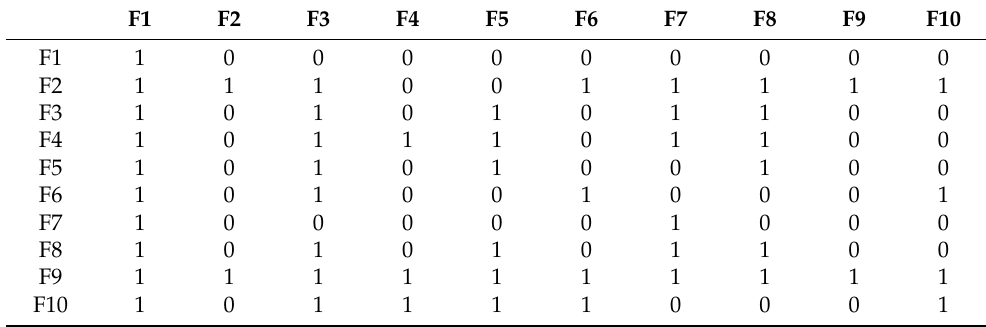
Table 2. Initial reachability matrix factors influencing green operations strategies in healthcare.